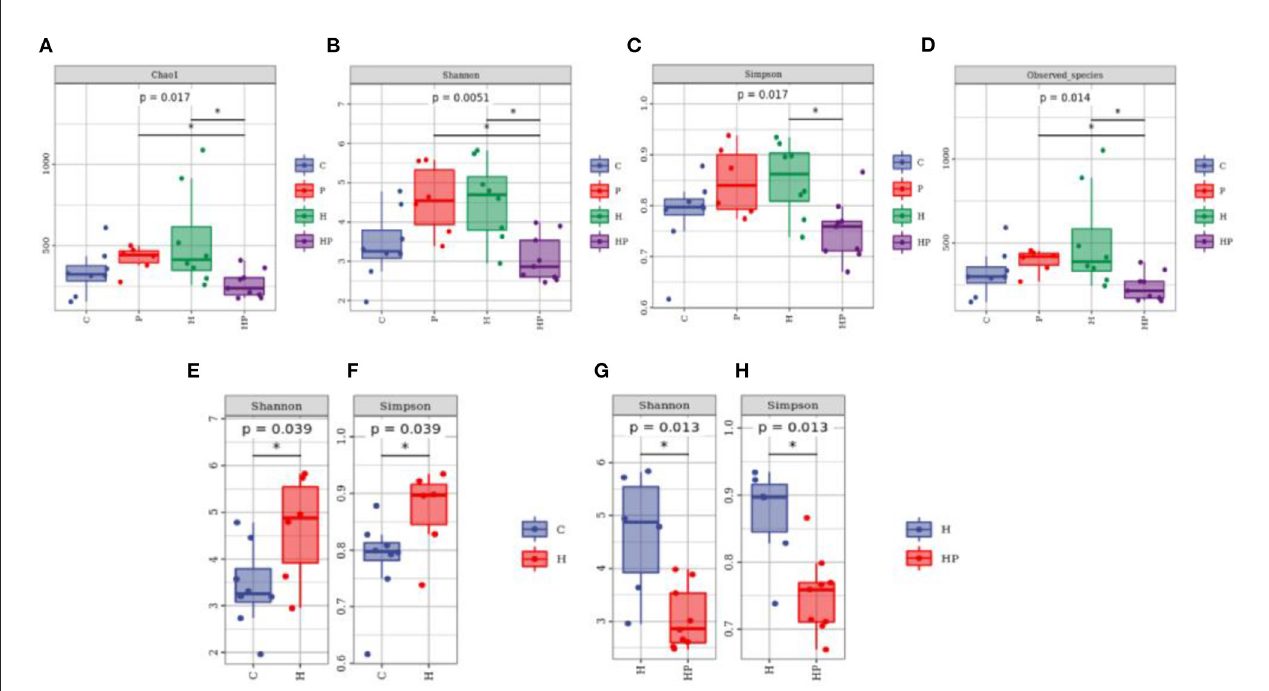
FIGURE2 Boxplots of alpha diversity indices of gut microbiota community based on 16S rRNA sequencing. (A–D) Gut microbial alpha diversity of C, P, H and HP groups based on (A) Chao1, (B) Shannon, (C) Simpson, and (D) Observed species. All data are normalized to C group (100%) (* p < 0.05). (E, F) Gut microbial alpha diversity of C and H groups based on (E) Shannon, and (F) Simpson. All data are normalized to C group (100%) (* p < 0.05). (G, H) Gut microbial alpha diversity of H and HP groups based on (G) Shannon and (H) Simpson. All data are normalized to H group (100%) (* p <